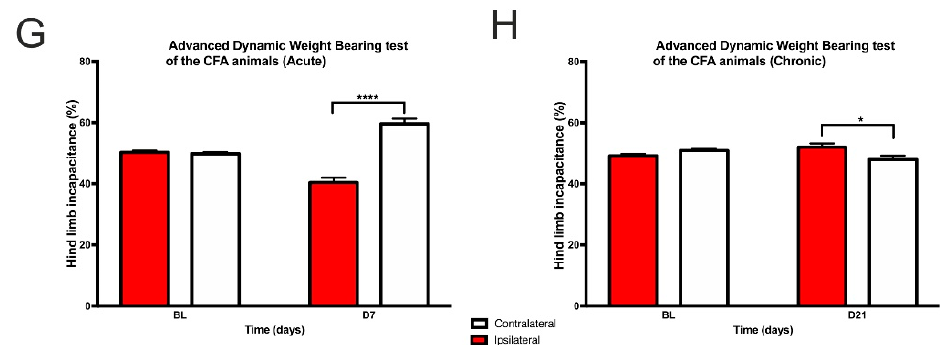
Figure 2. Behavioral testing revealed CFA-induced increase in pain sensitivity and edema of the inflamed hind limb. CFA-injected mice had reduced mechanonociceptive withdrawal threshold in acute ( A ) and chronic ( B ) inflammatory conditions, as revealed by the dynamic plantar aesthesiom- etry test. Mice with arthritis had increased thermal hypersensitivity in acute ( C ) and chronic ( D ) inflammatory conditions to noxious heat stimuli when tested with the hot plate test. CFA-treated animals developed sustained inflammatory edema both in acute ( E ) and chronic ( F ) conditions. Dynamic body weight distribution was also altered. Animals displayed bodyweight imbalance and reduced their bodyweight on the inflamed hind limbs during the acute phase ( G ), but this bodyweight imbalance was reversed on Day 21 in the Chronic CFA-treated animals ( H ). Y-axis of ( A , B ): mechanonociceptive withdrawal threshold. Y-axis of ( C , D ): latency of nocifensive reaction. Statistical analysis for A-F: two-way repeated measures ANOVA (time × CFA treatment) followed by Sidak’s multiple comparisons post hoc test. * p < 0.05; ** p < 0.01; **** p < 0.0001 versus control values at the same time point. Statistical analysis for G-H: two-way ANOVA (time × CFA treatment) followed by Tukey’s post hoc test. Abbreviations: baseline (BL); complete Freund’s adjuvant